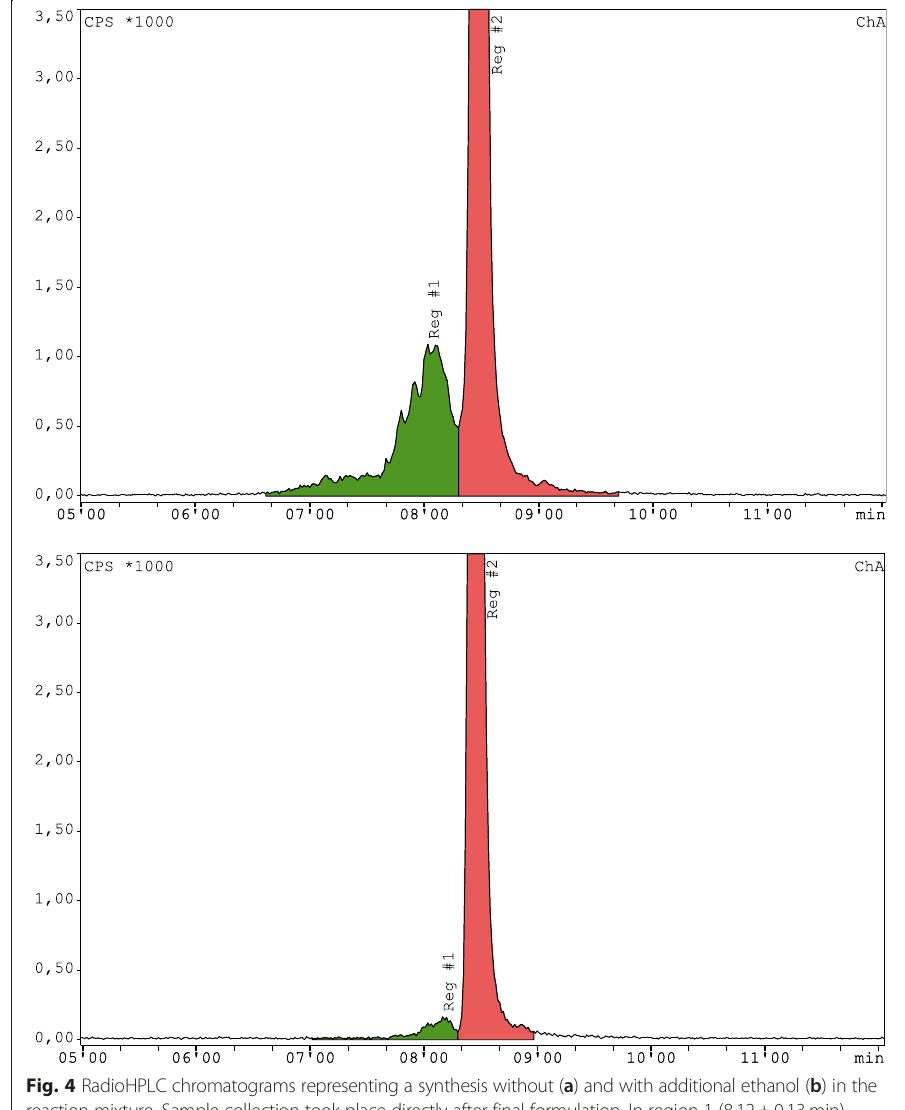
reaction mixture. Sample collection took place directly after final formulation. In region 1 (8.12±0.13min) radiolysis by-products can be found. The signal at 8.66±0.08min in region 2 indicates the